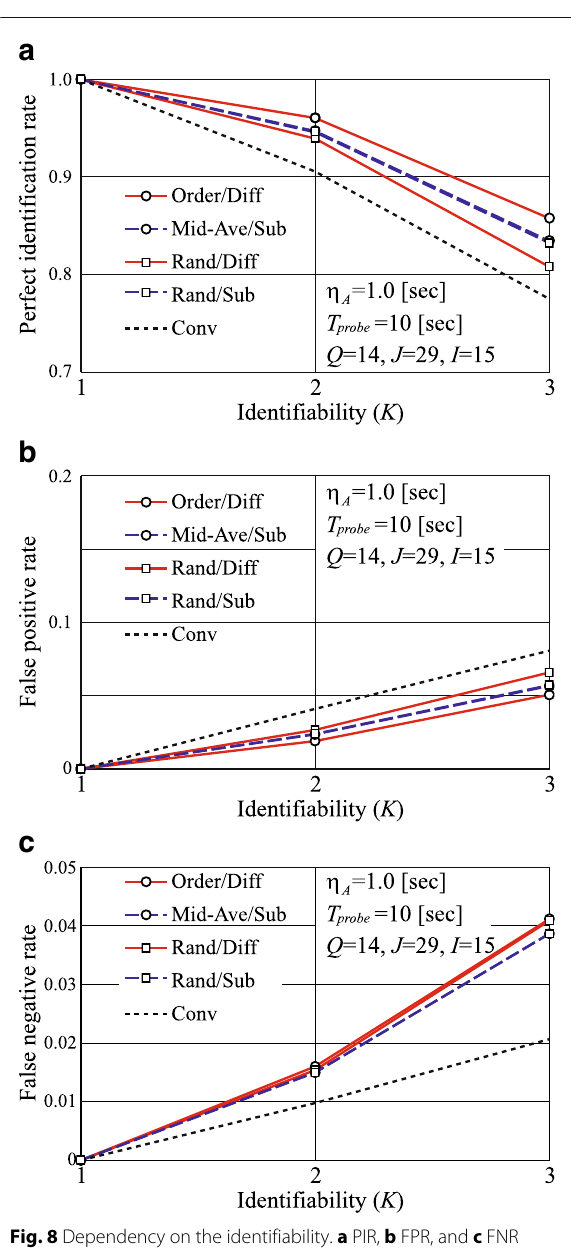
clock skew, and normal link delays in a realistic wireless sensor network by simulation experiments. The subtrac- tive scheme is simple, namely, does not care about the order of all measurement routes; it puts just a route as the reference at the middle of tomography session whose number of routes is closer to the average of those of links over all the measurement routes. On the other hand, the differential scheme is little complicated; it needs to